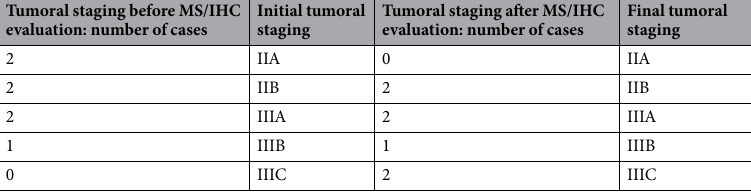
Table 3. Tumoral staging and restaging before and after the detection of micrometastasis to IHC and MS in patients operated by gastric carcinoma with known lymph node metastasis to hematoxylin-eosin (N = 7). MS – Lymph node multisection, IHC – immunohistochemistry.